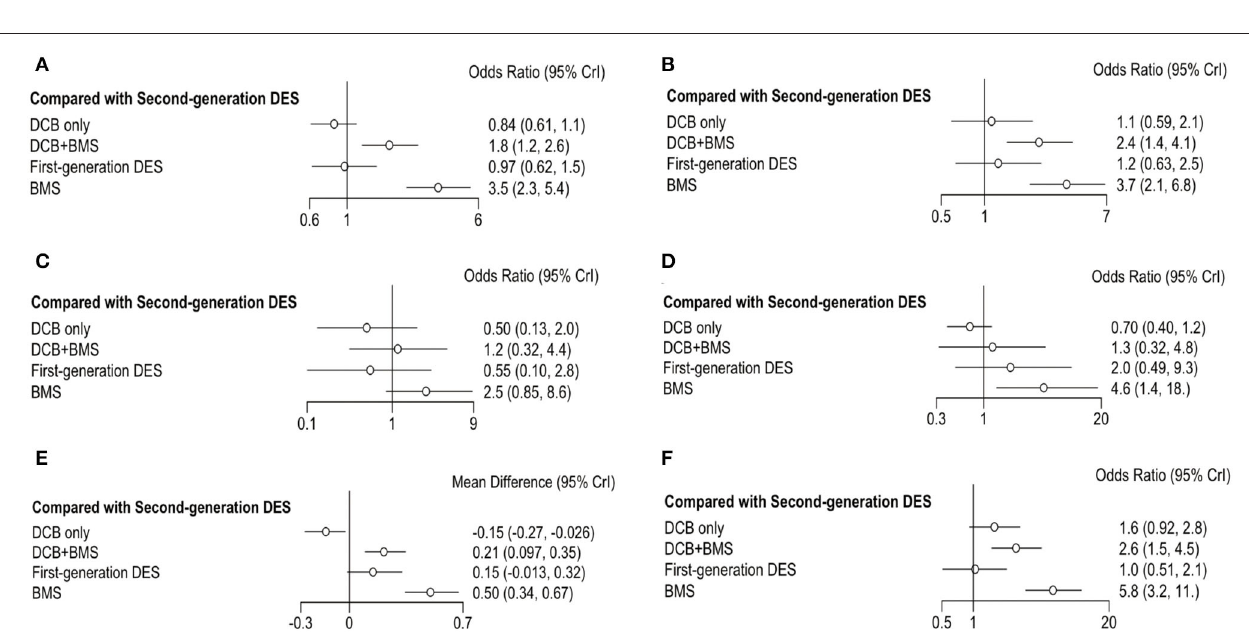
FIGURE 4 | Forest plots of entire cohort compared with second-generation DES. (A) MACE; (B) TLR; (C) all-cause death; (D) myocardial infraction; (E) LLL; (F) BR.